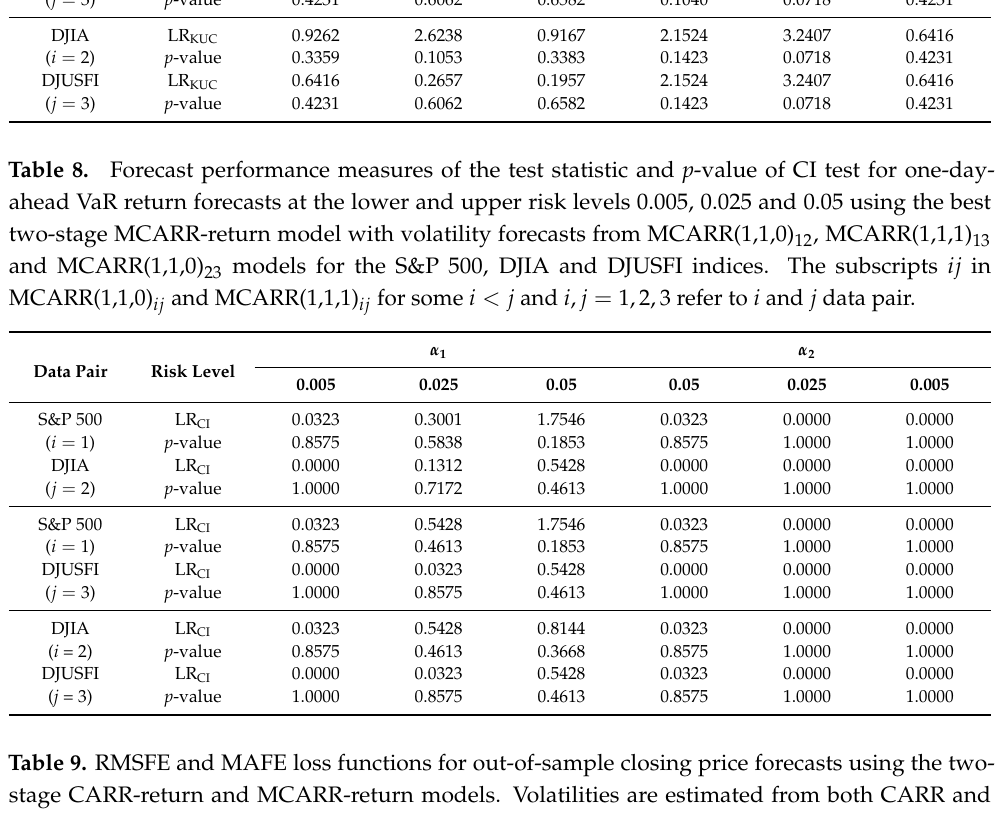
Table 9. RMSFE and MAFE loss functions for out-of-sample closing price forecasts using the two- stage CARR-return and MCARR-return models. Volatilities are estimated from both CARR and MCARR models for each of the S&P 500, DJIA and DJUSFI index series. The stage-two return models in the two-stage CARR-return and MCARR-return models use constant mean function and Student-t and MVT error distributions, respectively.